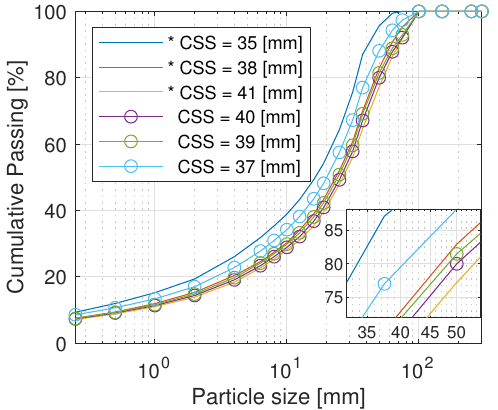
Figure 9. Measured PSDs for CSS = 35 mm, 38 mm and 41 mm. Predicted PSDs for CSS = 37 mm, 39 mm and 40